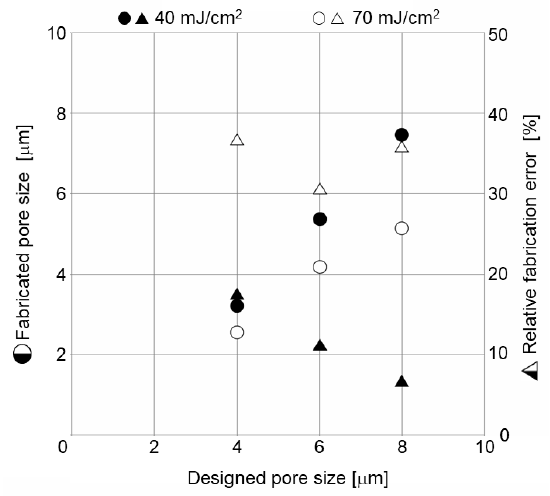
Figure 5. The size and the relative fabrication error of the pores on the fabricated MIS. There was no structure when it was fabricated with an exposure energy of 30 mJ/cm 2 .